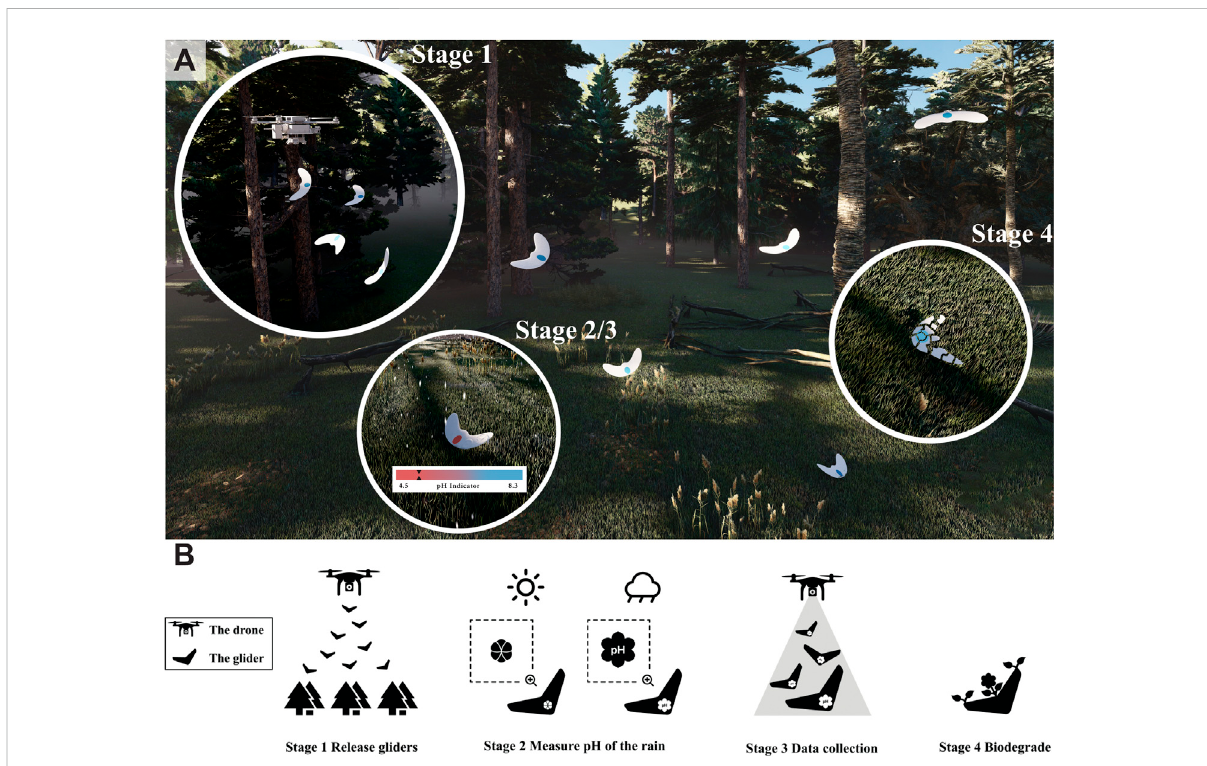
FIGURE 1 Overview of the proposed transient glider deployment in nature. (A) Conceptual illustration of the robot ’ s deployment (stage 1), the pHdetectionanddatacollection(stage2/3)andtheglider ’ sbiodegradation(stage4), (B) Missionpro fi leofthetransientrobot.AfterreleasebyaUAV, the gliders land on the ground. When exposed to rain, the humidity actuator opens up and exposes the embodied pH sensor to the potentially acid rain. The color change corresponds to the acidity of the rain